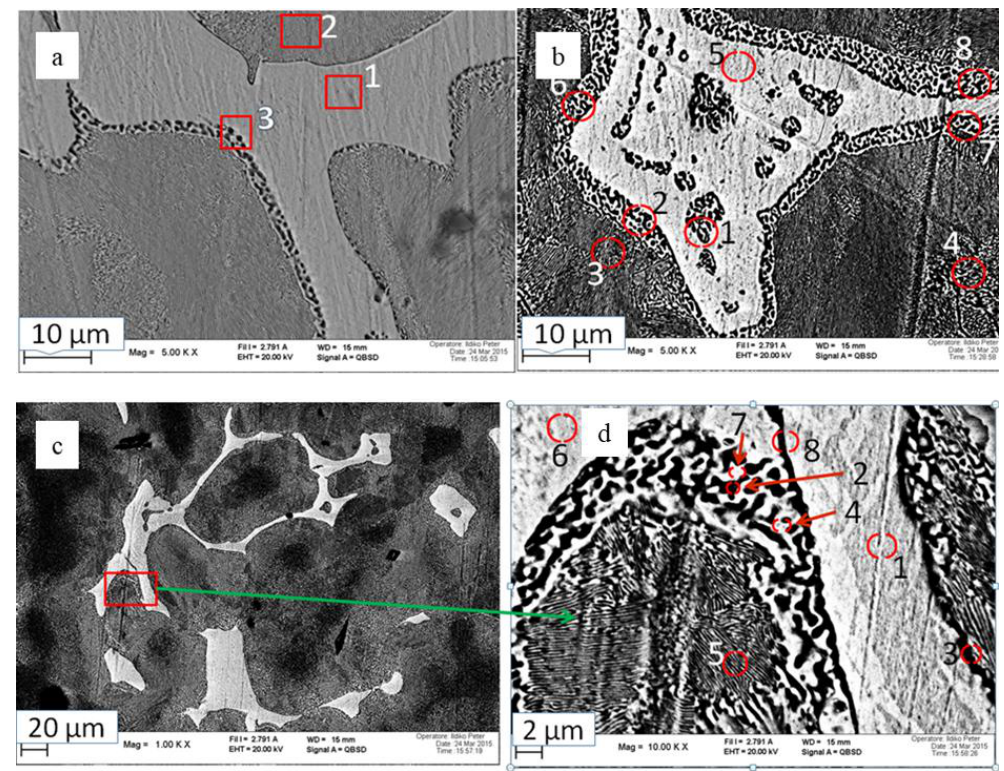
Figure 4. Indication of the different ( a – d ) areas for the ZnAl22 alloy cast with steel die